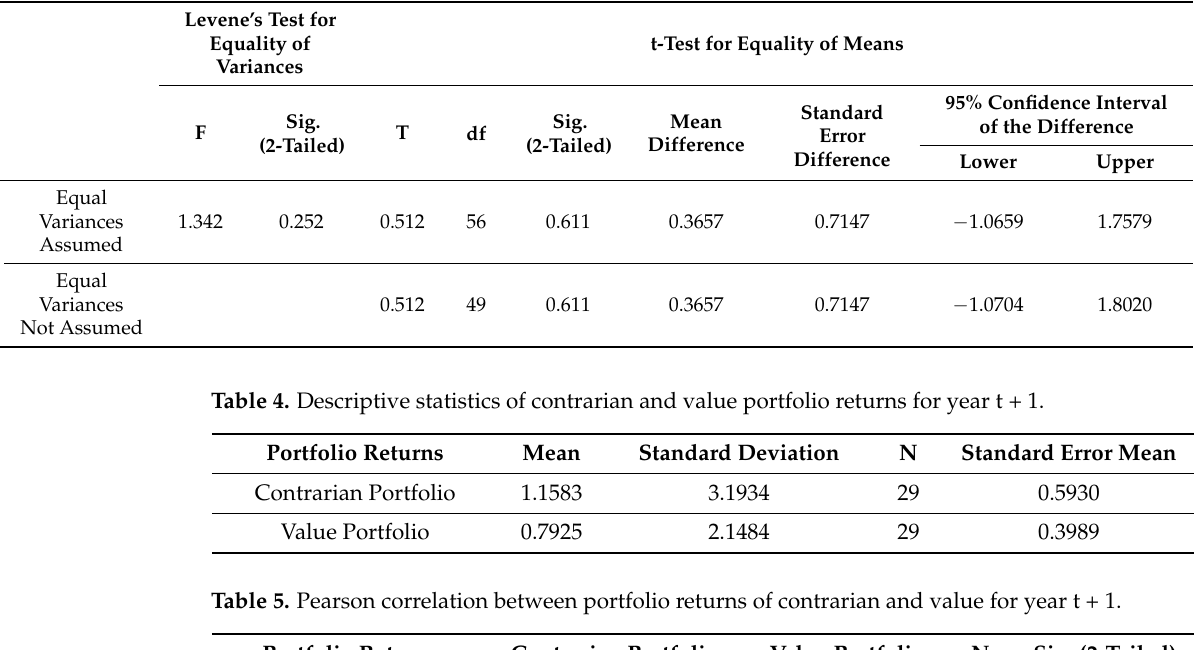
Table 3. Independent samples test for contrarian and value portfolio returns for year t + 1.